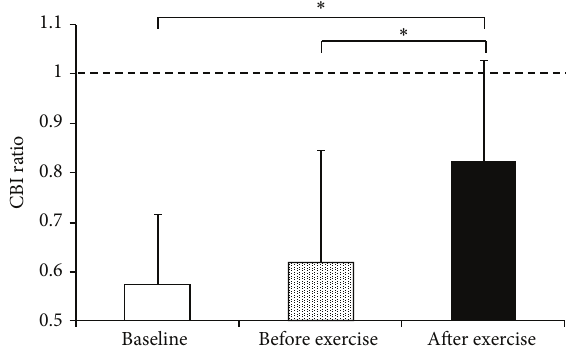
Figure 3: CBI ratios averaged across the group. A value of 1.0 on the 𝑦 -axis (depicted by dashed line) indicates the amplitude of the TS alone. Asterisks indicate statistical significance ( 𝑝 < 0.05 ). Error bars represent one standard deviation. CBI: cerebellar